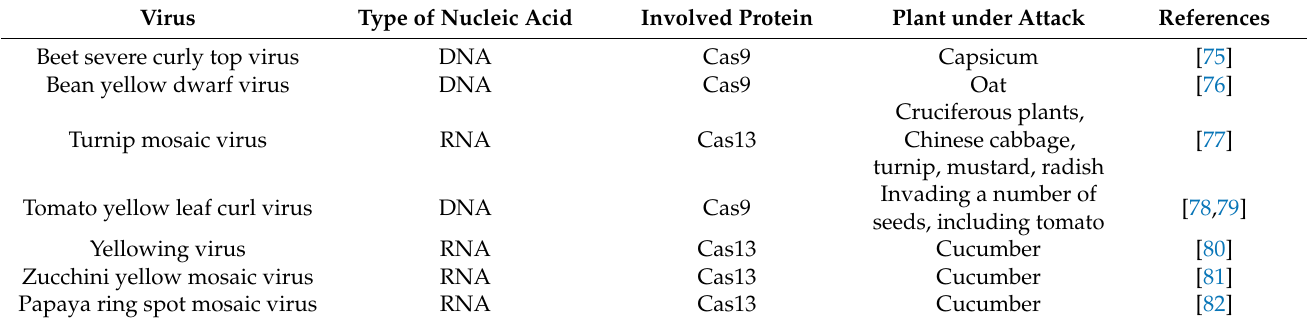
Papaya ring spot mosaic virus